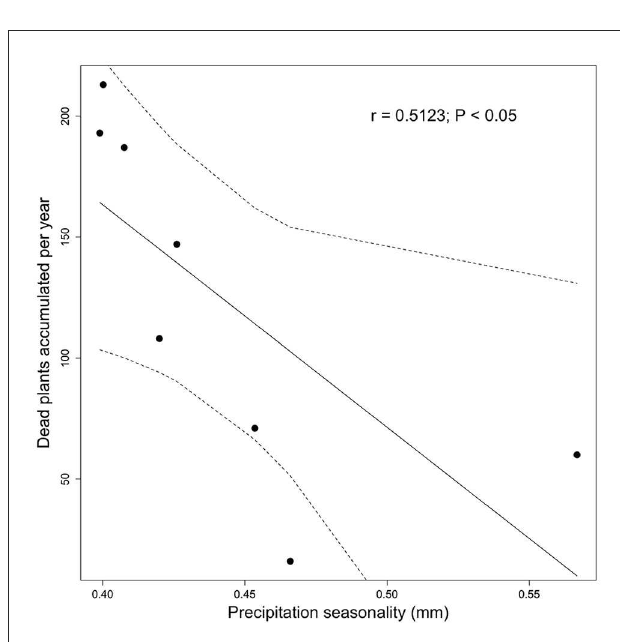
FIGURE4 Precipitation seasonality vs. dead plants accumulated per